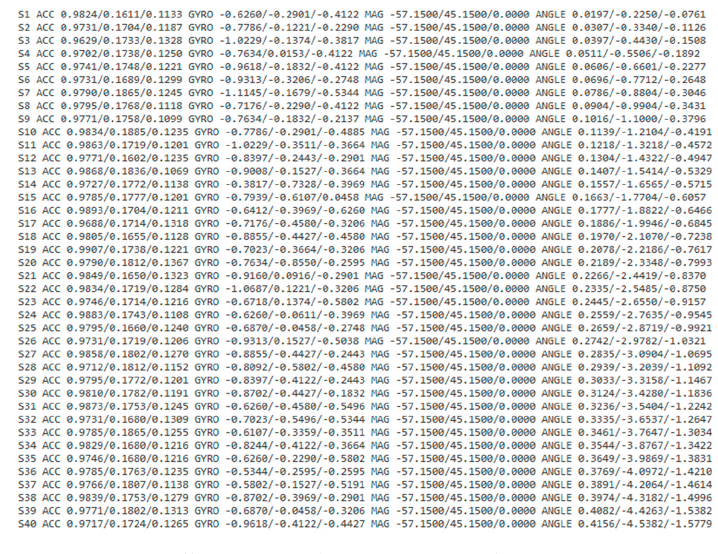
Figure 6. Data collection console screen using Eclipse Maxim SDK.